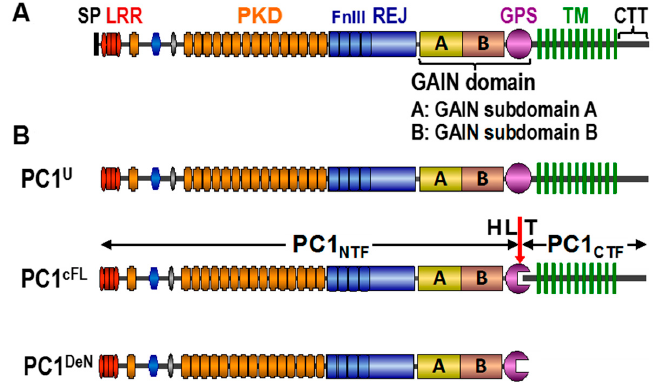
Figure 1. A schematic diagram of the domain organization of polycystin-1 and various products generated by cleavage at the GPCR proteolysis site (GPS) motif within the GAIN domain. ( A ) Schematic diagram of the structure of polycystin-1. SP, signal peptide; LRR, leucine-rich repeat; PKD, polycystic kidney disease (PKD) domains; REJ, receptor for egg jelly module with its four fibronectin III domains (FnIII); GAIN, GPCR autoproteolysis-inducing domain; A, GAIN subdomain A; B, GAIN subdomain B; GPS, G-protein-coupled receptor proteolytic site motif; TM, transmembrane domain; CTT, C-terminal tail. ( B ) Polycystin-1 products generated by GPS cleavage. PC1 U , uncleaved full-length PC1; PC1 cFL , cleaved full-length PC1 in which the two cleavage fragments, PC1 NTF and PC1 CTF , remain non-covalently associated within the GAIN; the HL*T tripeptide within the GPS motif is indicated; PC1 deN , a separate form of the PC1 NTF molecule derived from PC1 cFL once it has dissociated from PC1 CTF